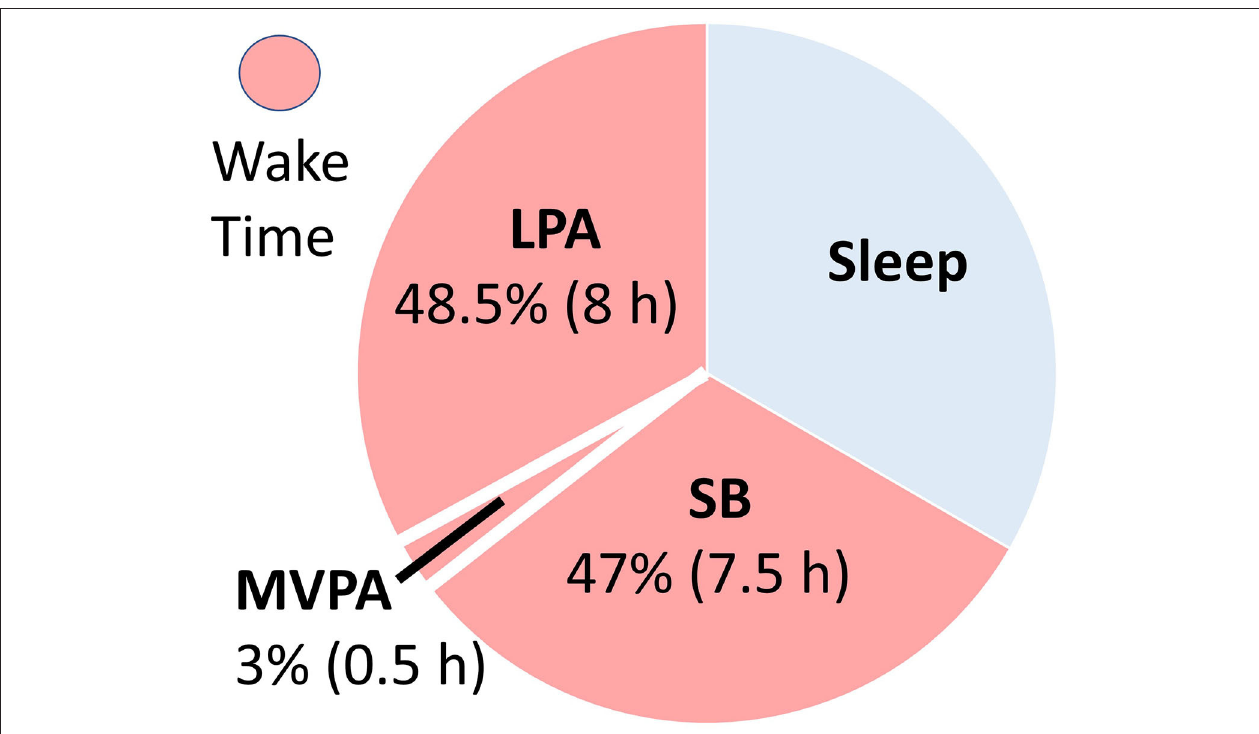
FIGURE 1 | Example of a typical 24-h activity cycle for individuals in modernized economies. The average adult engages in sedentary behaviors (SB) ∼ half their waking hours, with the majority of the remaining waking hours engaged in light physical activity (LPA). Time spent in moderate-to-vigorous physical activity (MVPA) is typically minimal ( ∼ 3% of the day), even for adults meeting recommended